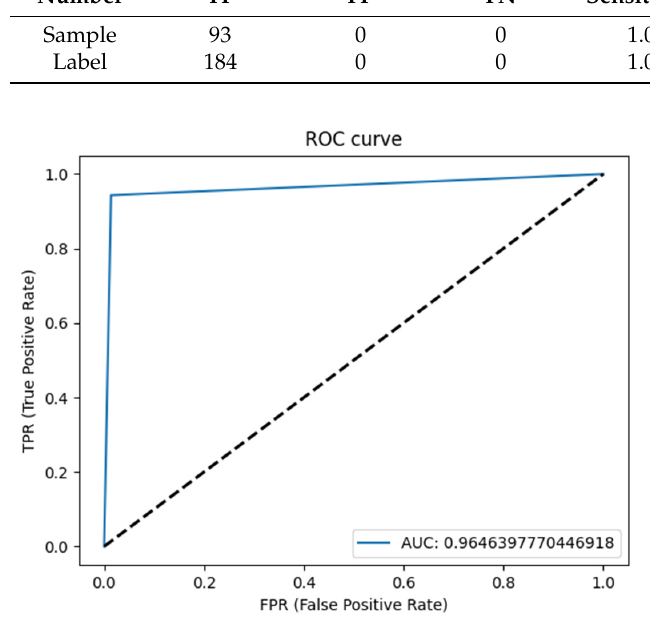
Figure 4. Precision–Recall curve. 4. Discussion As new developments occur in terms of deep learning and neural techniques, artifi- cial intelligence is being increasingly integrated into the field of medicine, and artificial intelligence has been used to solve clinical problems. Recently, at the same time as deep learning techniques are being used in the medical field, its application in dentistry has also increased. In the current study, the technique employed offers a comprehensive train- ing approach to optimize the usage of datasets that have been partly annotated for the purpose of segmenting organs. Segmenting organs with precision and reliability can help to improve clinical applications including computer-aided detection, treatment, and sur- gical procedures. Organ segmentation also has the potential to be a critical factor in edu- cating dental students [16,30,31]. Our study enables the segmentation of distinct IT images using a single network. To take advantage of the data from large scale datasets, previous researchers have adopted semi-supervised approaches in which the data were labeled weakly or potentially had no labels. This study is supplementary to previous approaches,